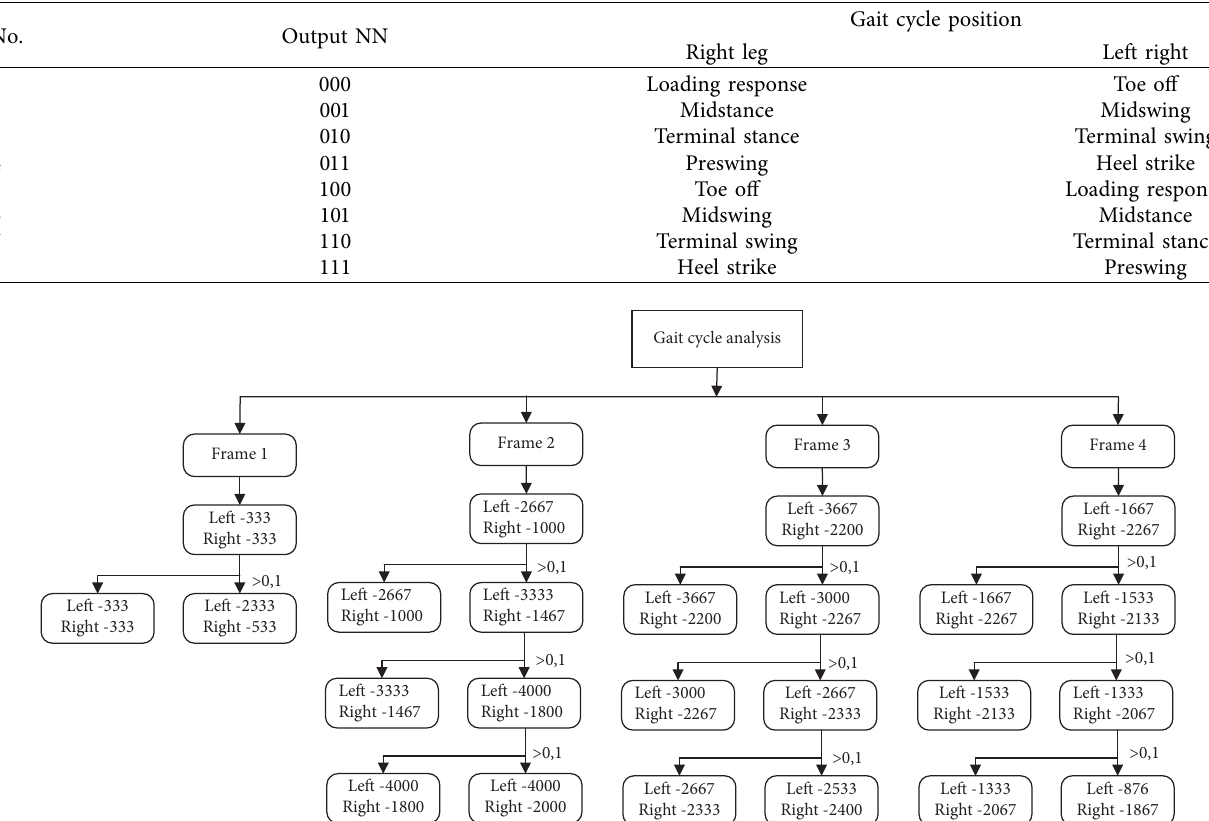
Figure 6: Decision tree scheme for the generation of assistive torque for the left